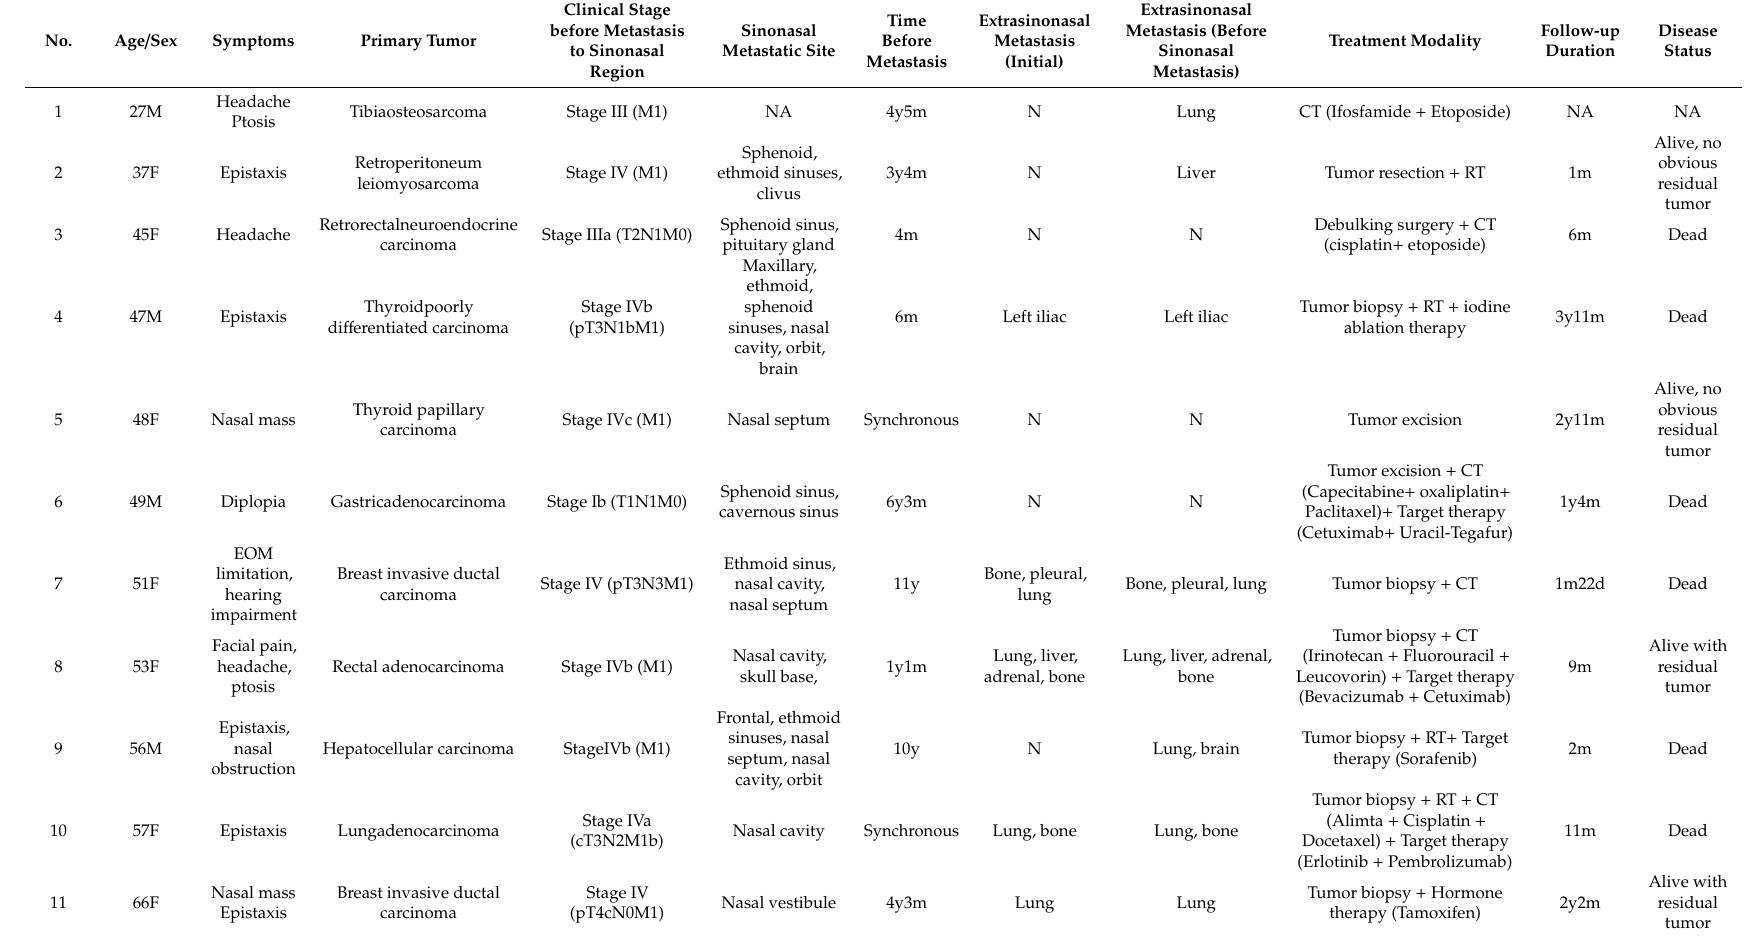
Table 3. Summary of the cases of sinonasal metastatic cancer in our